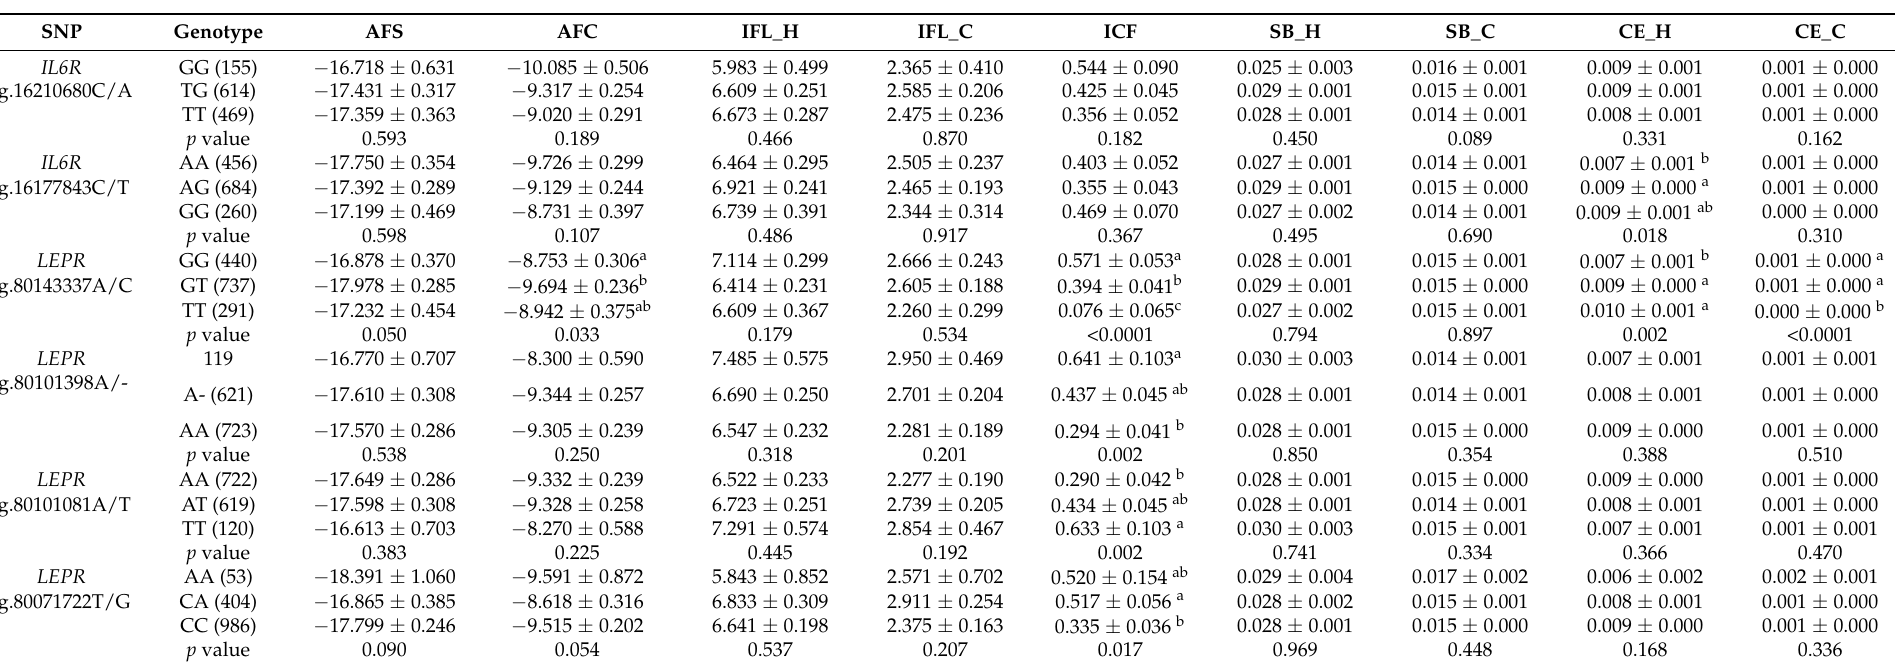
Table 2. Association of SNPs within gene IL6R and LEPR with reproductive traits in Holstein cows (least square mean ± standard